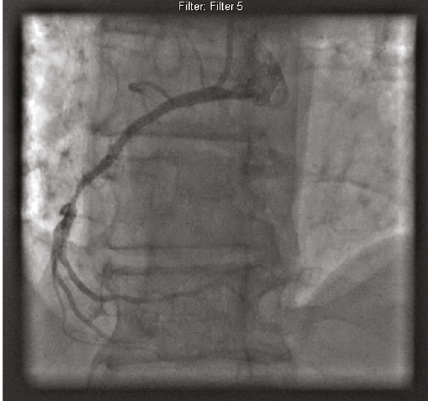
Figure 2: Right coronary artery with severe residual stenosis post balloon angioplasty and stenting.